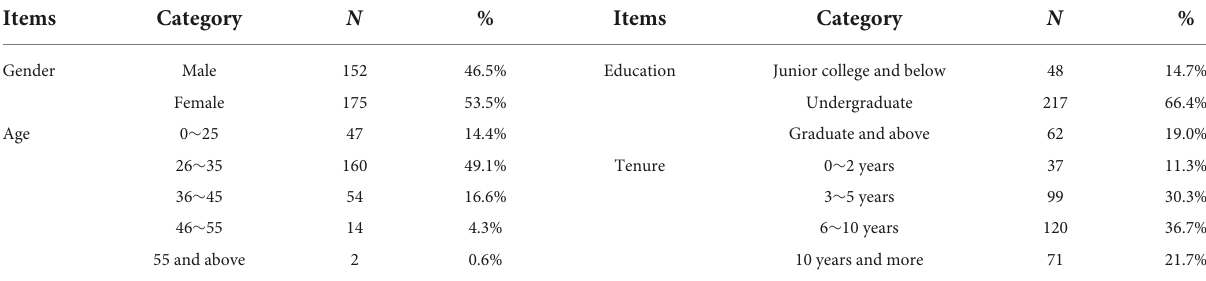
TABLE 1 Basic information of sample ( N =